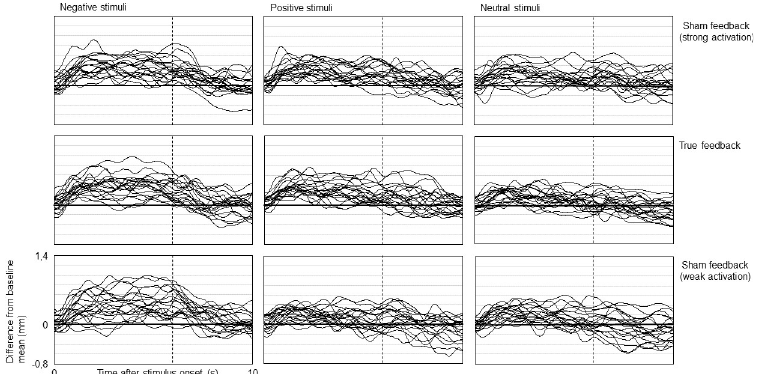
Fig 3. Individual averages of pupil size changes during experimental conditions. Individual averages (n = 24) of pupillary reactions to auditory stimuli from negative, positive and neutral categories while providing true feedback (middle row) and sham feedback suggesting strong and weak activation (upper/lower row). Signal courses depict differences from baseline mean (set to zero on the y-axis). Vertical dotted lines indicate end of stimulation (after six seconds). For purposes of presentation, curve progressions are smoothed using a sliding average of half a second (30 data points).